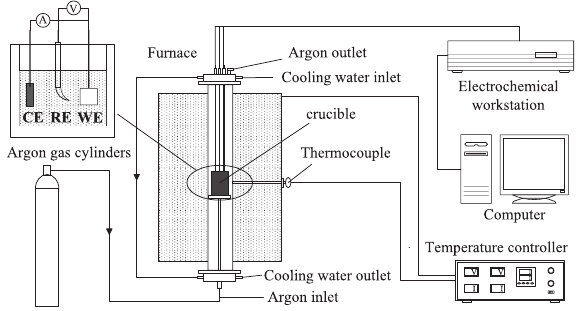
Figure 1: The equipment of electrochemical process.